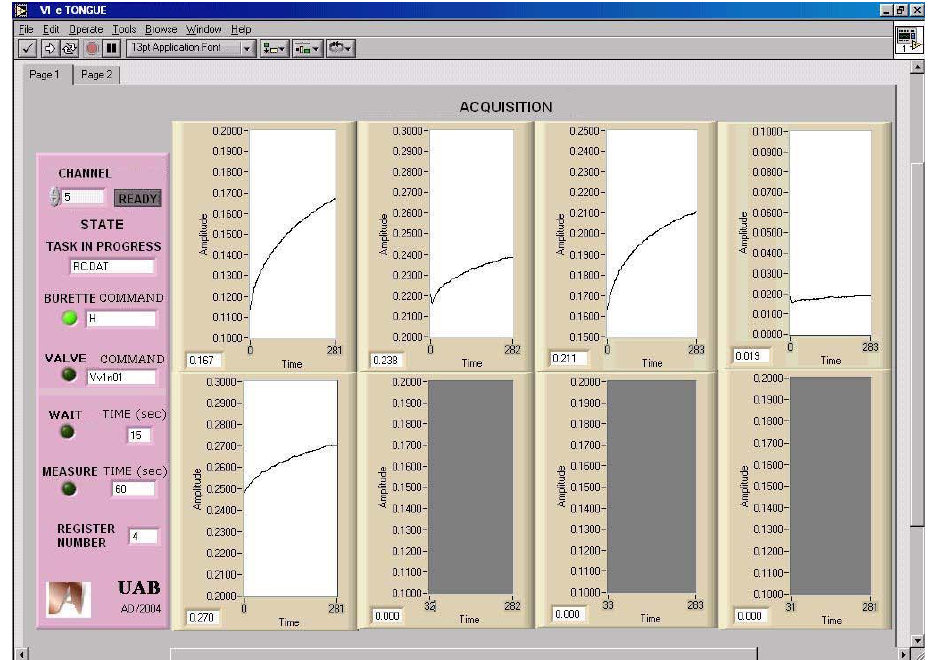
Figure 5. Front panel VI. Acquisition of 5 potentials during sensor transient